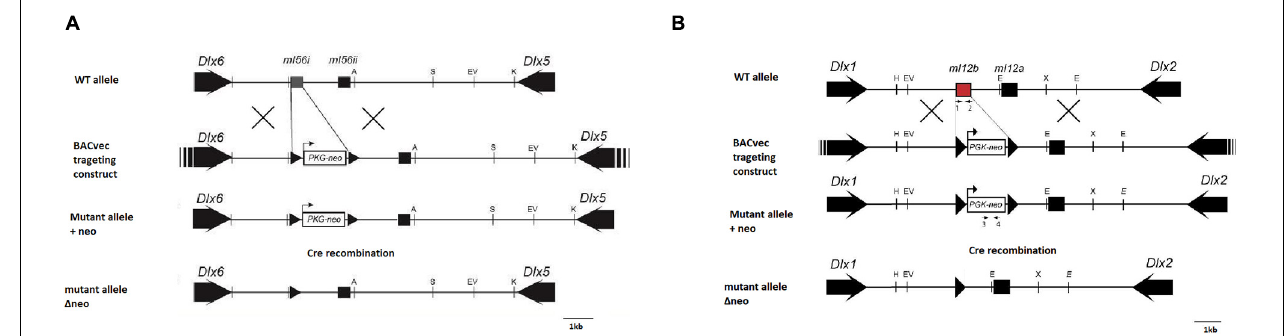
FIGURE 1 | Targeting strategy for the generation of mutant mice with deletions of forebrain Dlx enhancers. (A) Strategy for the deletion of enhancer I56i. (B) Strategy for the deletion of enhancer I12b. Homologous recombination in embryonic stem cells was completed using a BAC targeting construct wherein the enhancer was replaced with a floxed neomycin cassette. Recombinant clones were transferred into a blastocyst to generate chimeric embryos. Mice positive for the recombinant Dlx loci were crossed with CRE mice to remove the neomycin cassette. Black arrows, transcriptional orientation of each gene; black triangles, lox p locations. A, Age I; H, Hin dIII; S, Sal I; E, Eco RI; EV, Eco RV; K, Kpn I; X, Xba I.